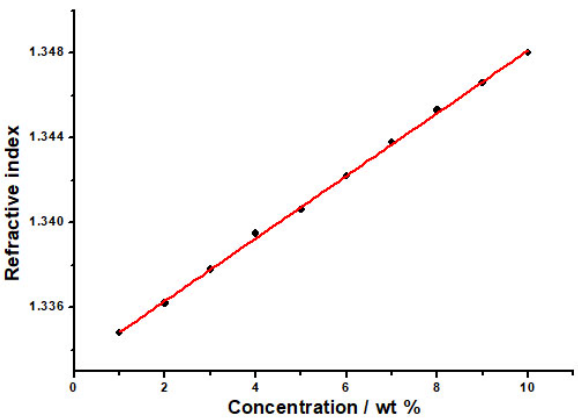
Figure 3. The relationship between the RI of PVP aqueous solution and mass fractions (wt%).